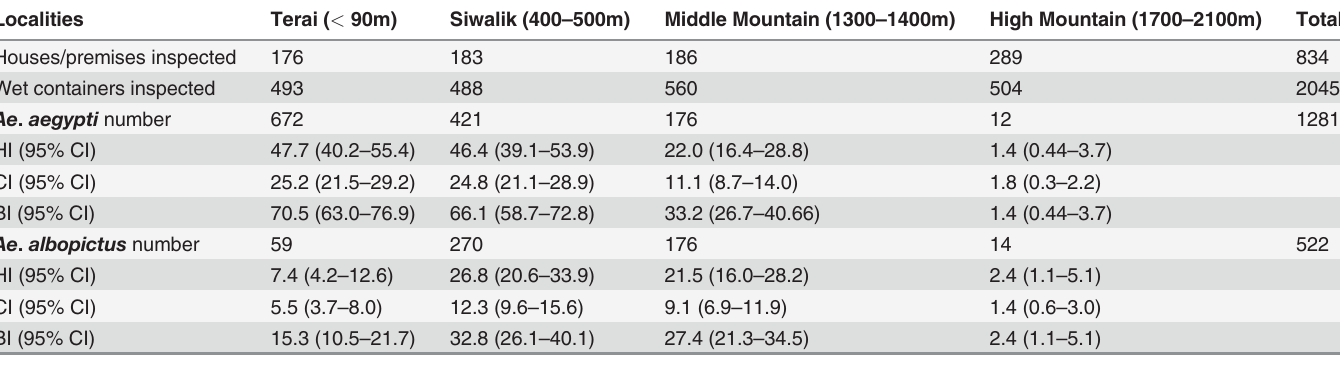
Table 1. Stegomyia indices of Aedes aegypti and Aedes albopictus in central Nepal. Localities